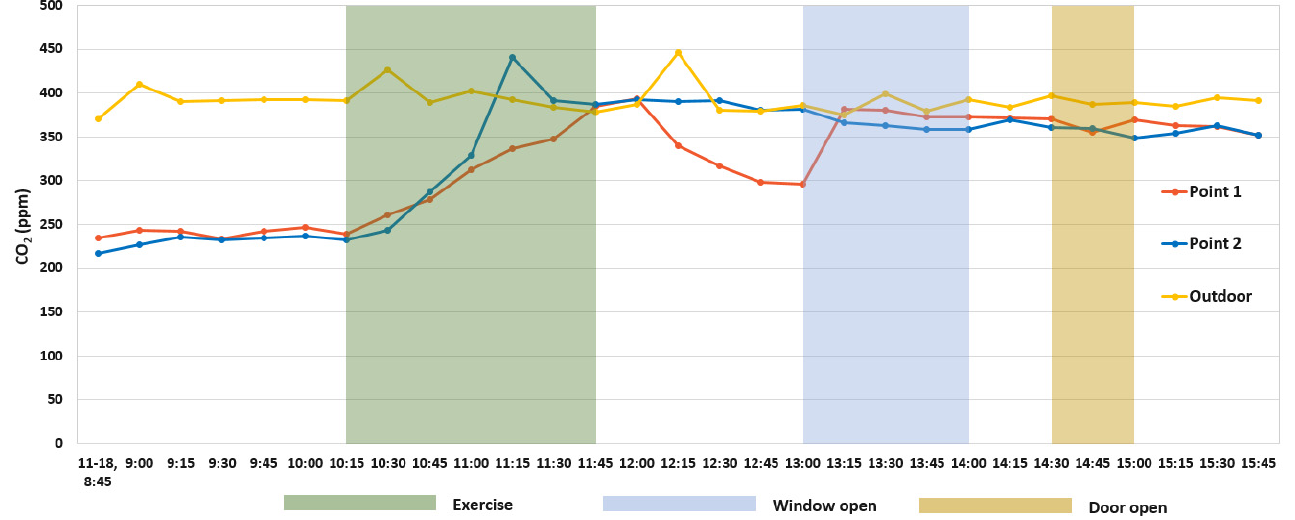
Figure 10. Change in the CO 2 concentration as a function of physical activities and window/door openings in the MPA-space of A elementary school on 18 November 2020.